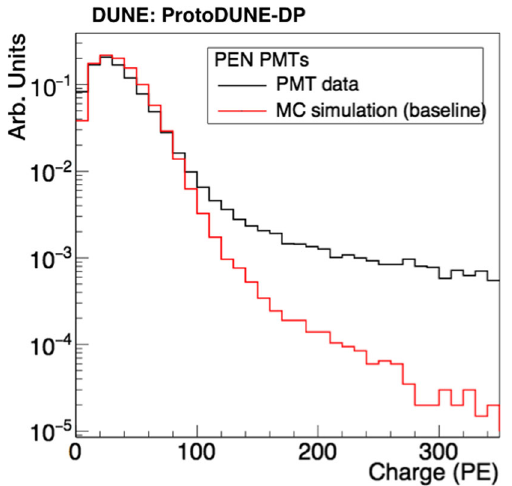
Fig. 14 Normalized distributions of the collected S1 charge for CRT triggered light data and simulation